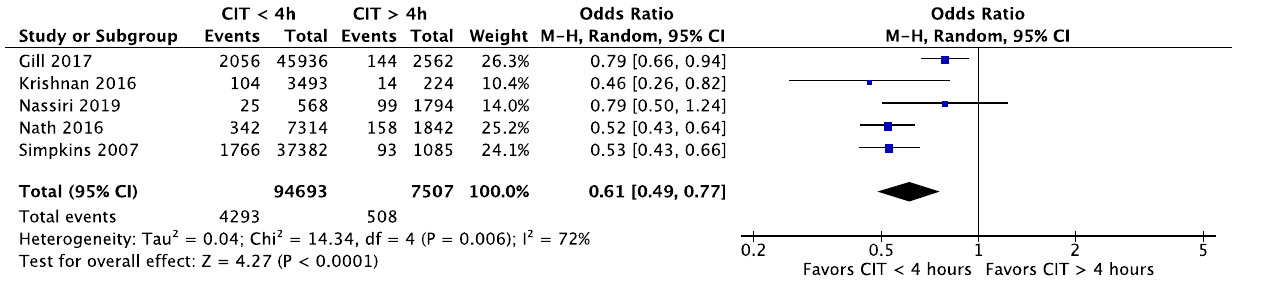
Figure 2. The incidence of DGF for CIT shorter and longer than 4 h. CIT: cold ischaemia time; DGF: delayed graft function.